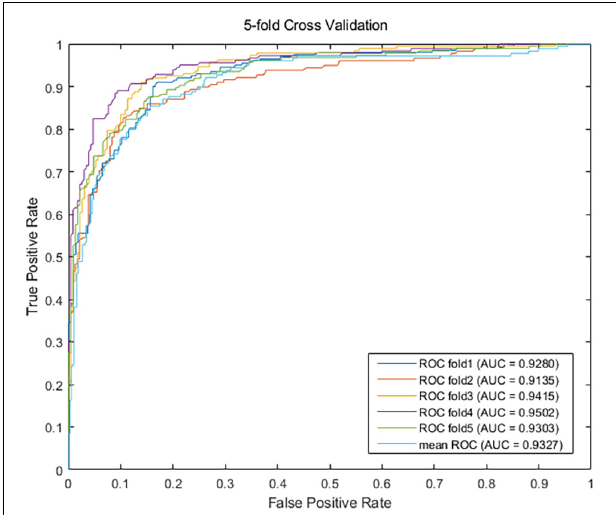
FIGURE 2 | The ROC curve of EMC-voting by one time fivefold